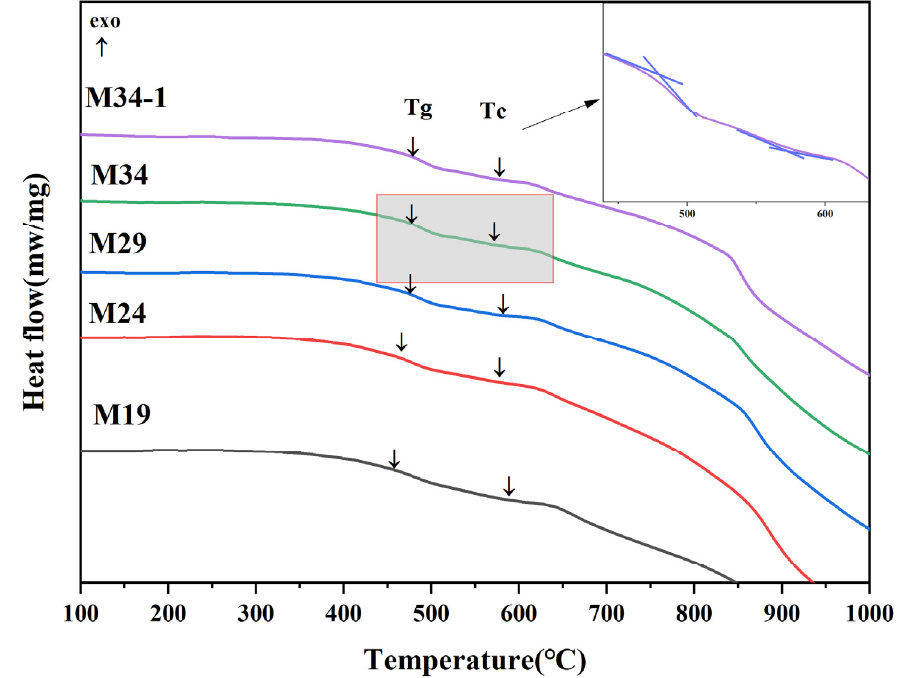
Figure 5. DSC curve of Mz series.